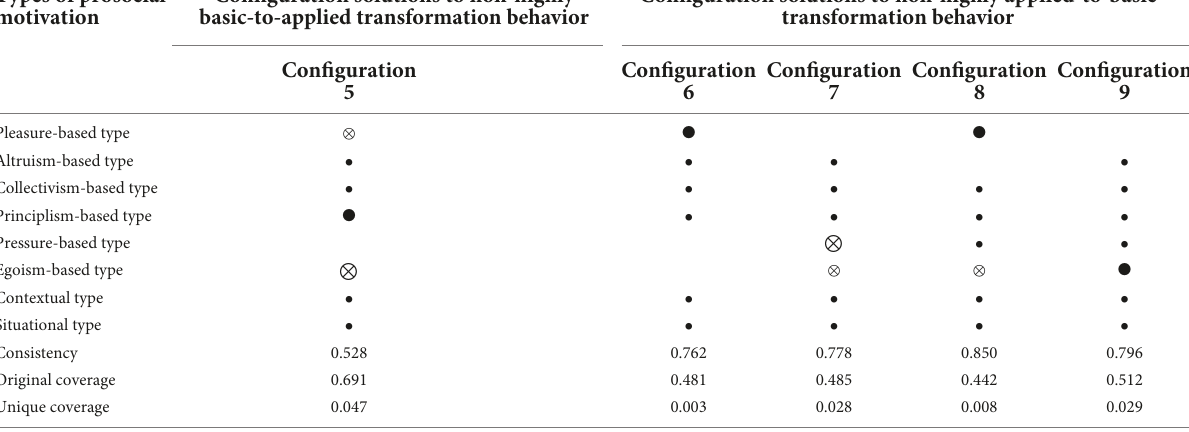
TABLE 8 Configuration solutions to non-high transformation behaviors between basic research and applied